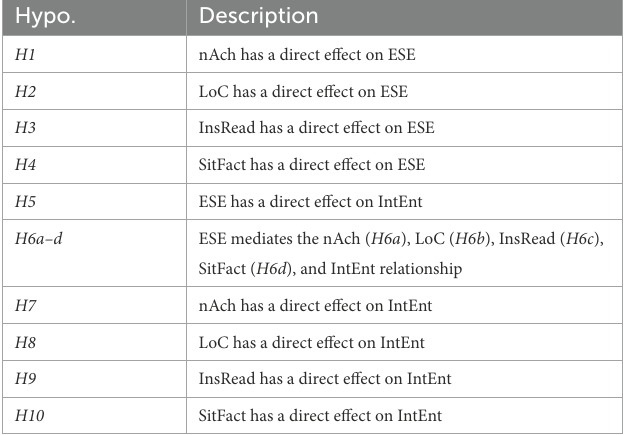
TABLE 1 Study hypotheses. Hypo.